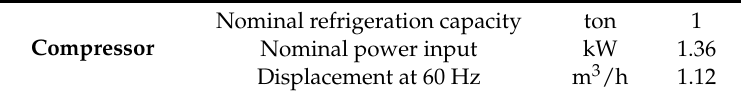
Table 1. Semi hermetic compressor.